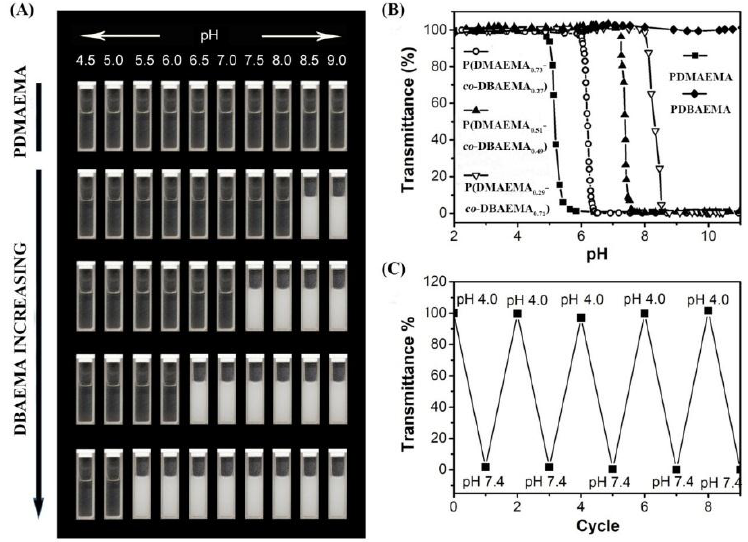
Figure 3. ( A ) Optical images of (co)polymer solutions at different pH. ( B ) The transmittance curves of (co)polymer solutions with increasing pH values. ( C ) The pH reversibility study of PDBAEMA solution with cycles between pH 4.0 and pH 7.4.